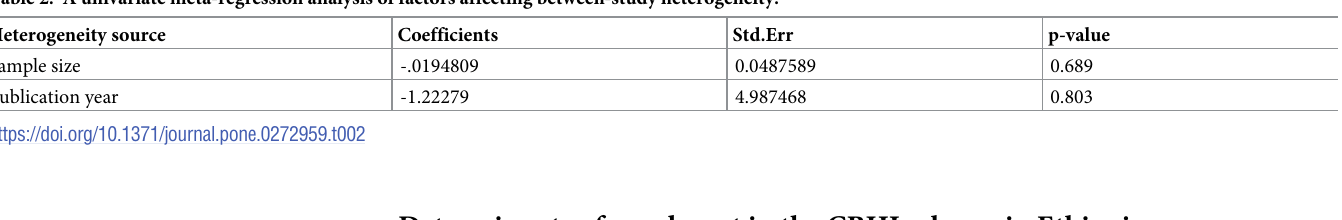
PLOS ONE | https://doi.org/10.1371/journal.pone.0272959 August 18,